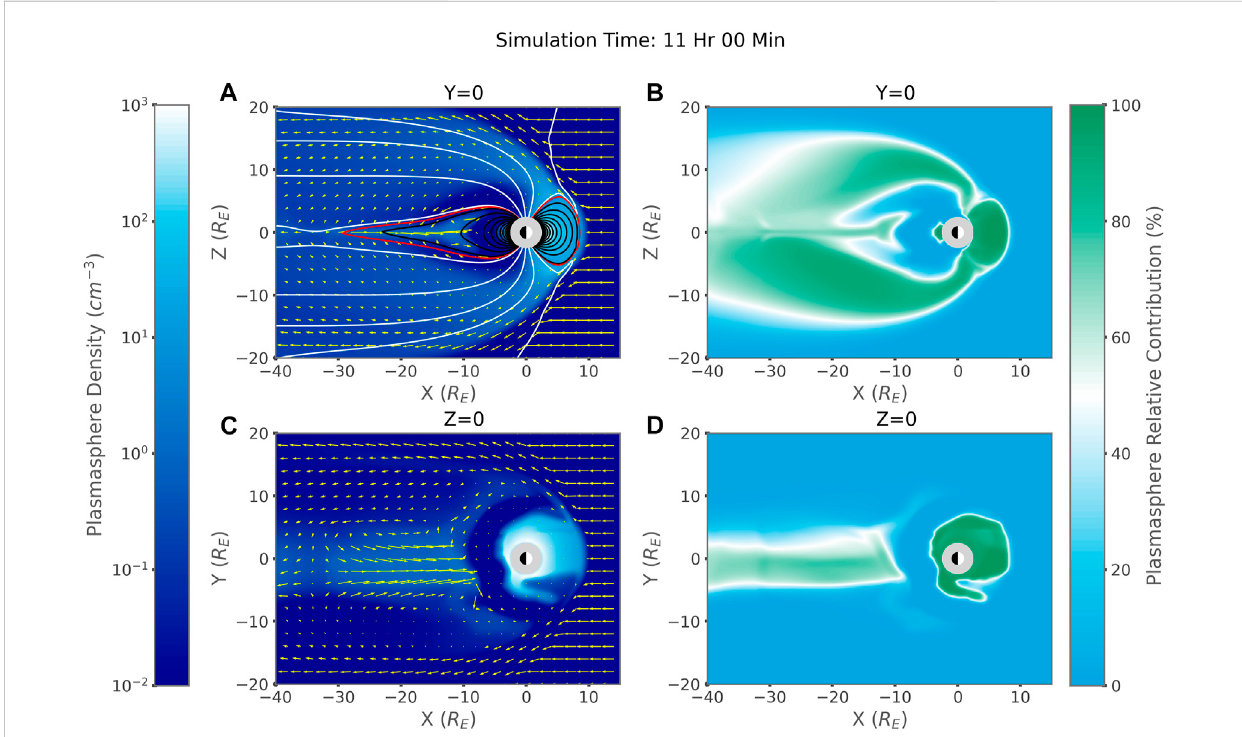
FIGURE 10 (A) Y= 0slice showing thedensity oftheplasmasphere fl uid, plasmasphere fl uidvelocityvector fi eld, and magnetic fi elds.White magnetic fi eldlines are open, black are closed, and red is the last closed magnetic fi eld line. (B) Y = 0 slice showing the relative contribution to the total density of the plasmasphere fl uid. (C) Z=0sliceshowingthedensityoftheplasmaspheric fl uid,plasmaspheric fl uidvelocityvector fi eld.Yellowarrowsinbothplotsare thevelocityoftheplasmasphere fl uid. (D) Z=0sliceshowingtherelativecontributiontothetotaldensityoftheplasmasphere fl uid.Allplotsarefrom 11 h into the Idealized CIR event simulation. This time approximately corresponds to the maximum relative contribution of the plasmasphere material to the total fl uence on the night side measurement